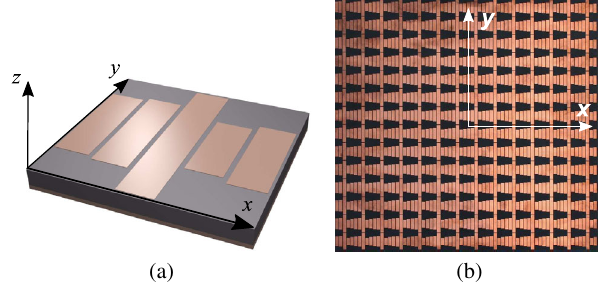
FIG. 5. (a) Schematic representation of one unit cell of the designed three-channel isolating mirror (retroreflector). (b) A photograph of the fabricated prototype.